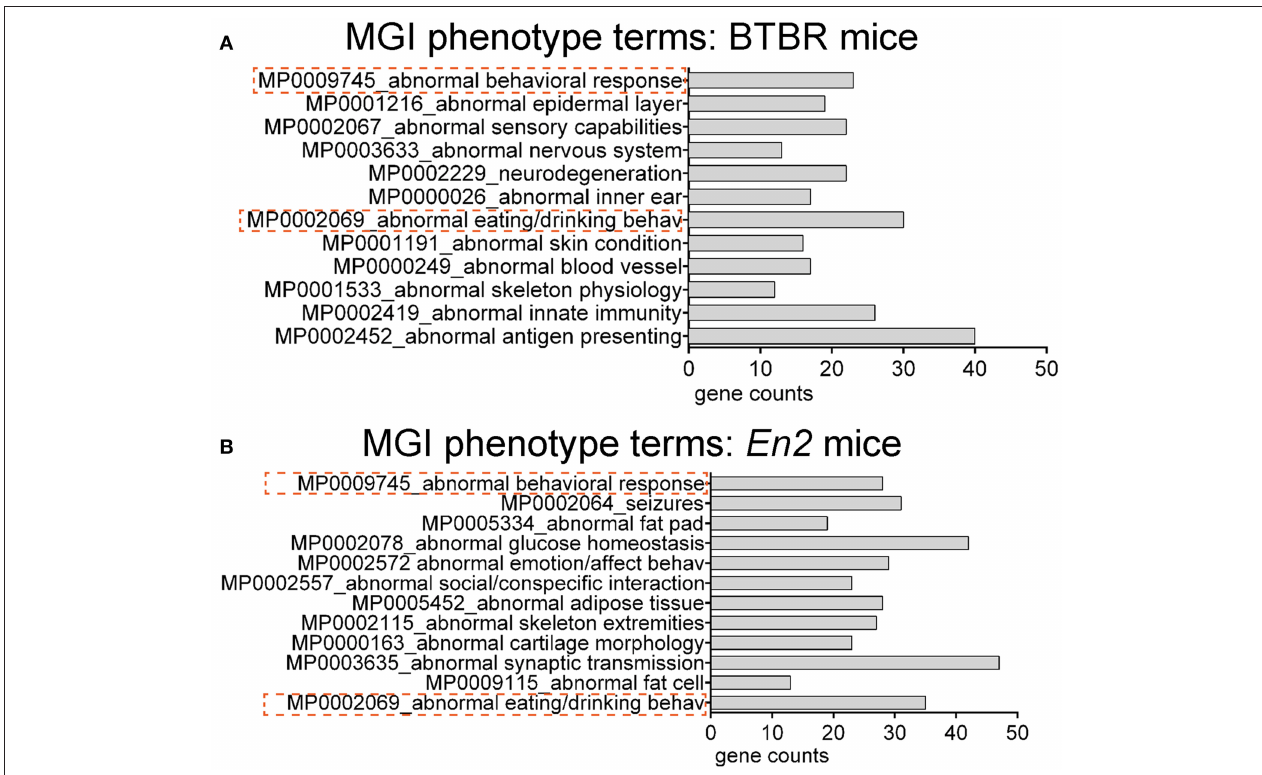
FIGURE 3 | Overrepresented mouse phenotype categories for differentially expressed genes in BTBR and En2 − / − hippocampi. BTBR and En2 − / − hippocampal DEGs were analyzed for enrichment in phenotype ontology categories using Enrichr, with an adjusted p < 0.05. For each category, the number of genes is indicated by the length of the horizontal bars (gene counts). Dashed red lines highlight phenotype categories common to BTBR (A) and En2 − / − (B)